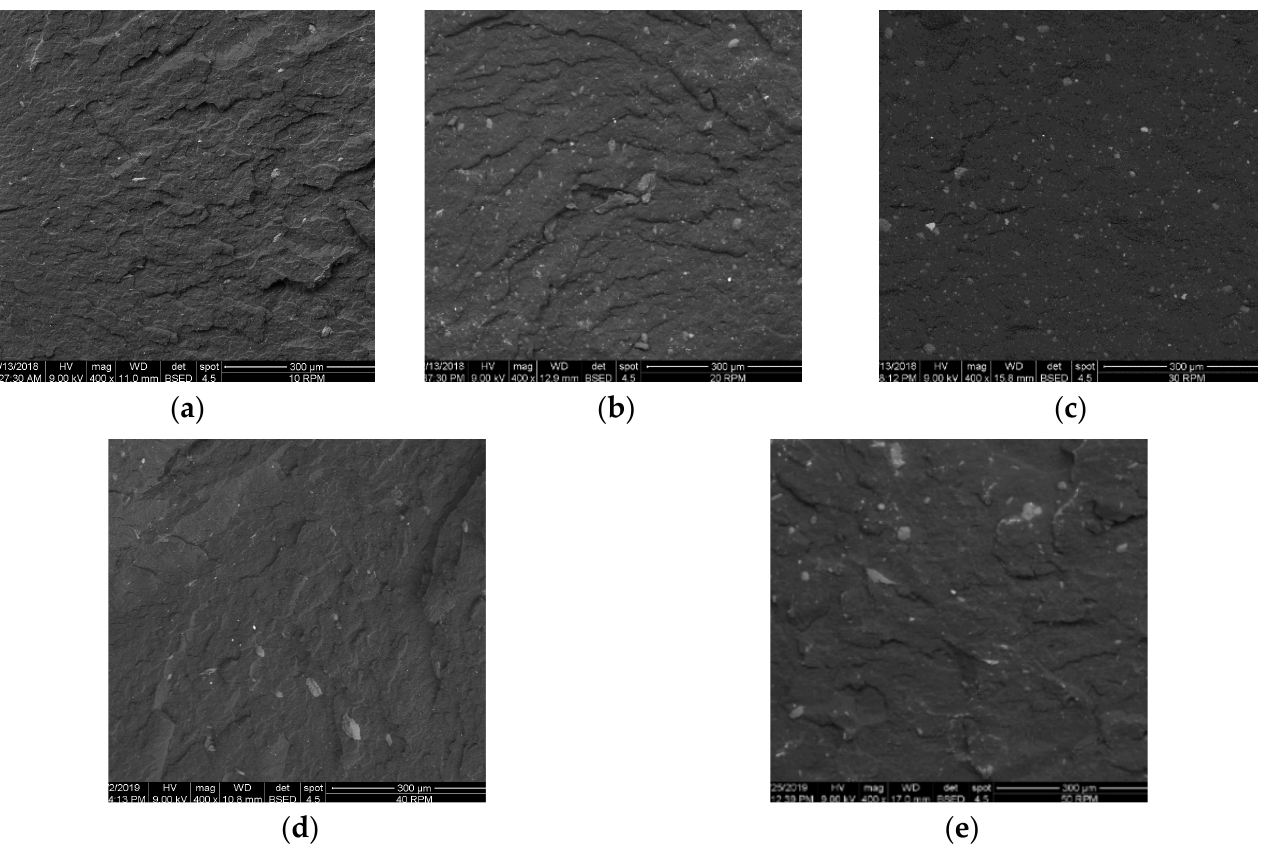
Figure 7. SEM images of the 97% rHDPE/rPP and 3% C20A blend at different screw speeds ( a ) 10 RPM, ( b ) 20 RPM, ( c ) 30 RPMm, ( d ) 40 RPM, ( e ) 50 RPM